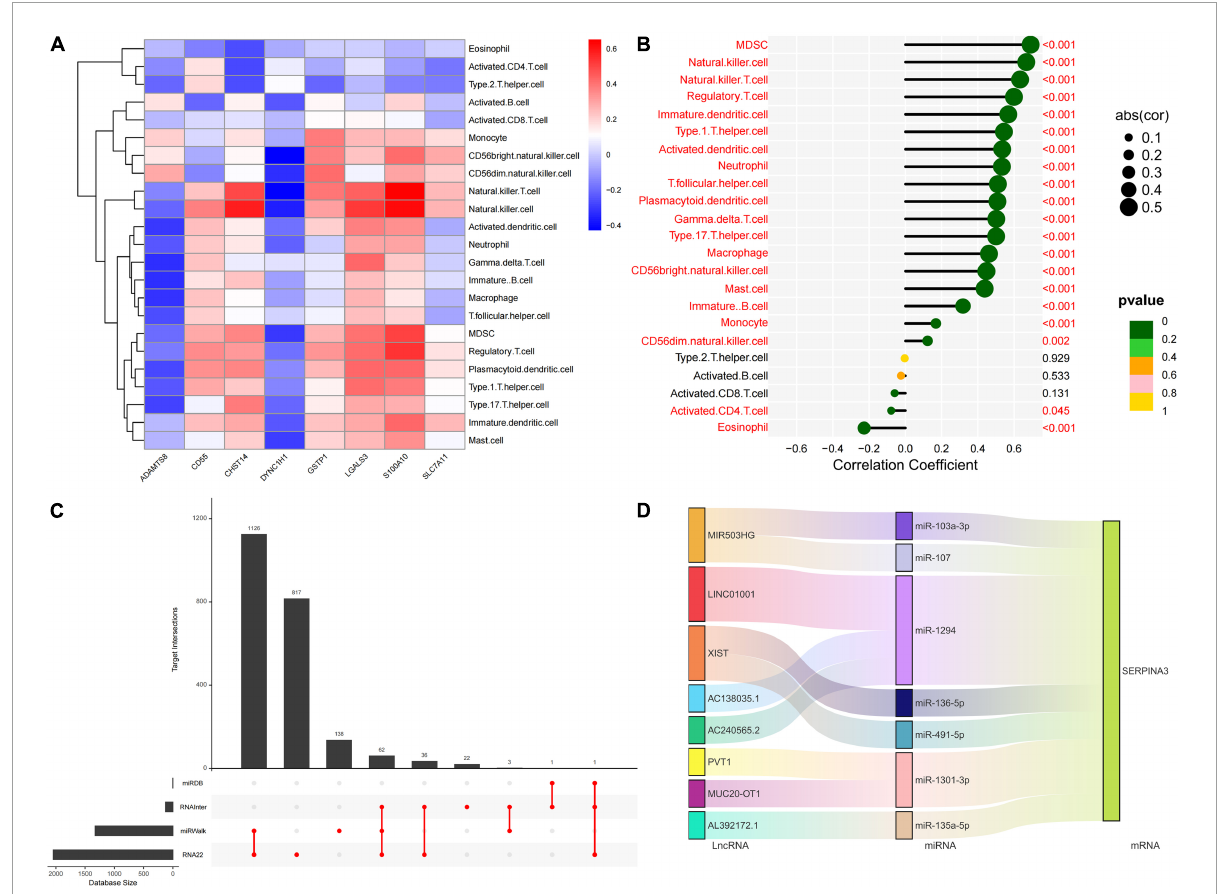
FIGURE5 Immune cell infiltration profiles across the key diagnostic marker subtypes and expression regulatory networks. (A) The correlation between the expression of eight core PGRGs and immune cell infiltration. (B) The correlation between the SERPINA3 gene and immune cells. (C) The intersection of miRNAs by which the expression of SERPINA3 is regulated in four databases. (D) The regulatory ceRNA network of SERPINA3